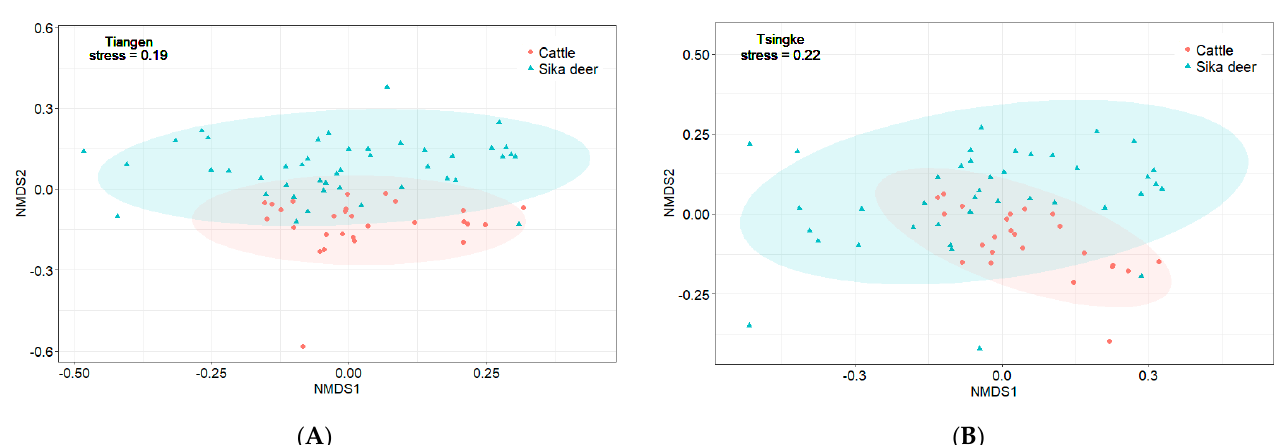
Figure 3. ( A )The main food in the diet of cattle and sika deer from Tiangen. ( B ) The main food in the diet of cattle and sika deer from Tsingke. Families with less than 5% dietary share were classified as “Other”. Significance between two species of the same family was compared and statistically significant differences are shown. *, 0.01 < p < 0.05; ***, p < 0.01.